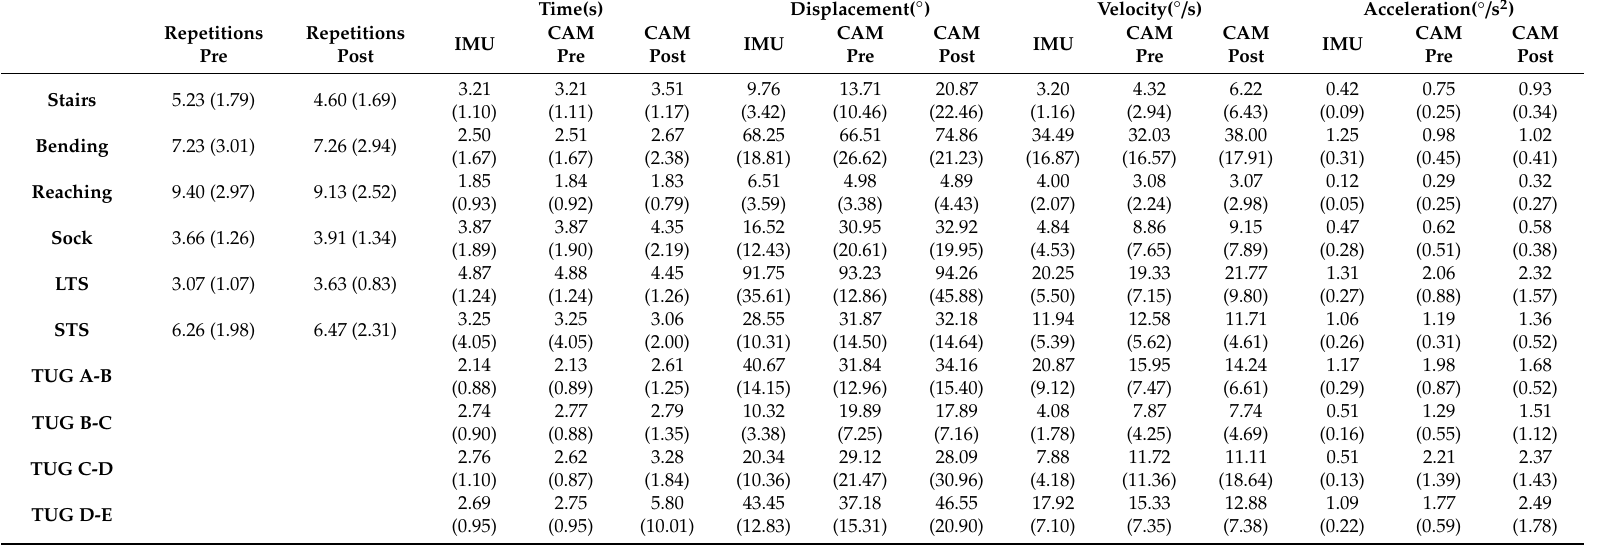
Table 2. Mean (standard deviation) of repetitions and the outcomes (time, displacement, velocity, and acceleration) from the kinematic tools during the functional tests (baseline and 1 month later). Inertial measurement unit (IMU); RGB-D camera (CAM); lie-to-sit (LTS); sit-to-stand (STS); timed up-and-go